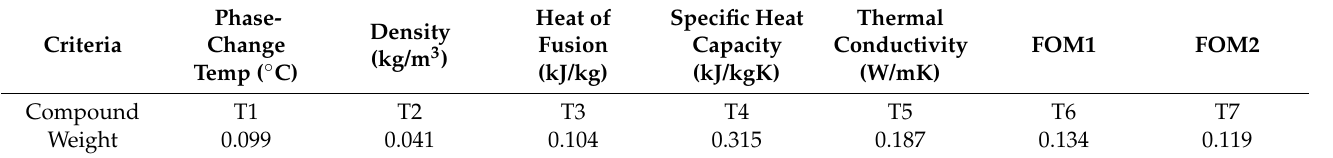
Table 7. Weighted criteria.